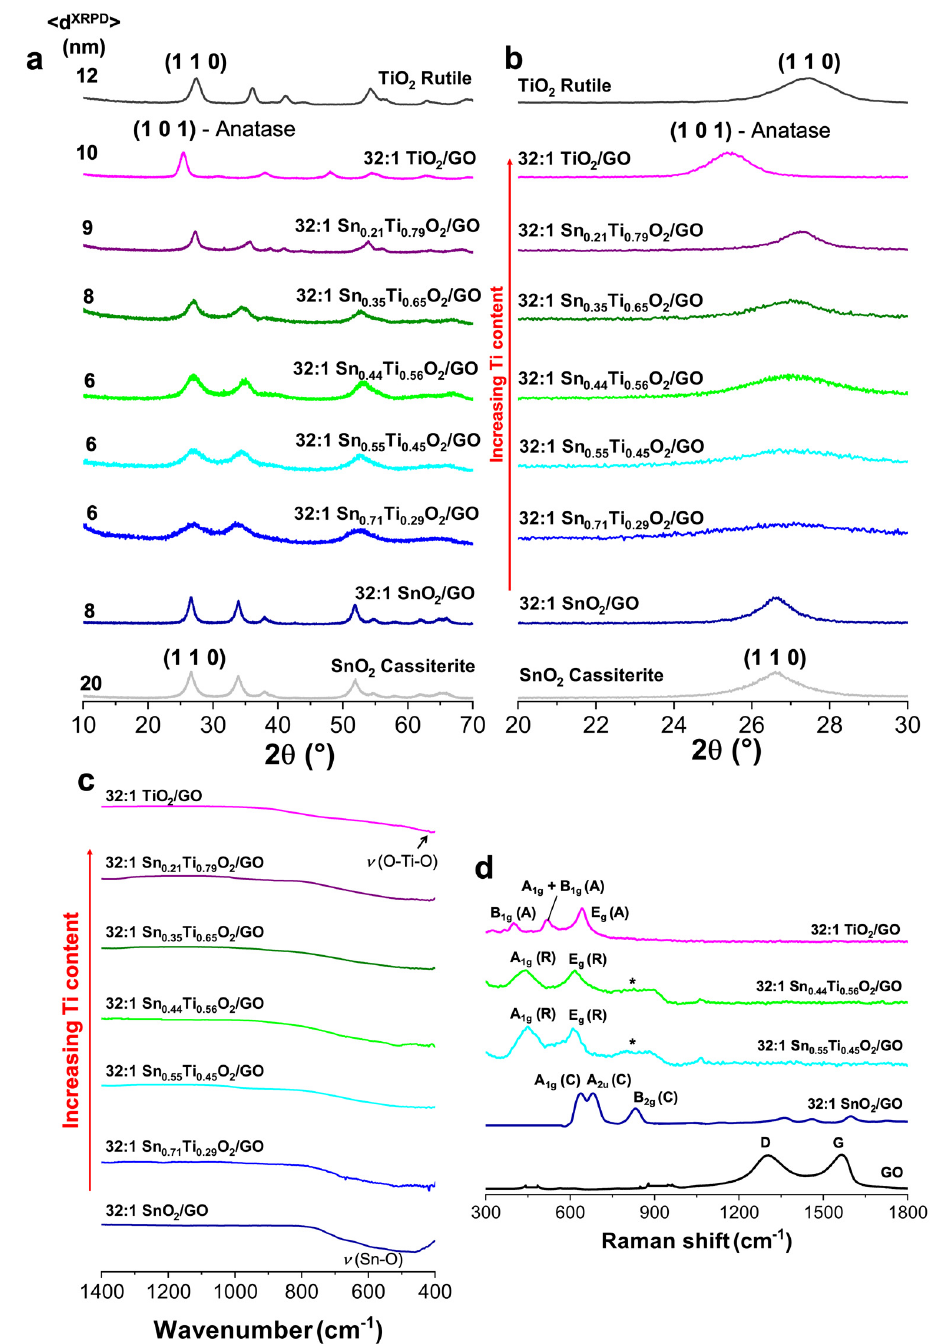
Figure 1. ( a ) Comparison of X-ray diffraction lines relative to pure cassiterite SnO 2 , rutile TiO 2 , 32:1 SnO 2 / GO, 32:1 TiO 2 / GO and all the Sn x Ti 1 − x O 2 / GO solid solutions by increasing the titanium content. ( b ) Magnification of the X-Ray Powder Diffraction (XRPD) patterns to investigate the shift of the more intense peak from 26.6 ◦ of pure cassiterite SnO 2 [40,45] to 27.4 ◦ of pure rutile TiO 2 [40]. ( c ) FTIR spectra of the tested samples, ( d ) Raman data of pure GO, 32:1 SnO 2 / GO, 32:1 TiO 2 / GO, 32:1 Sn 0.55 Ti 0.45 O 2 / GO, 32:1 Sn 0.35 Ti 0.65 O 2 / GO samples (A = anatase, R = rutile and C = cassiterite). * = Traces of SnO 2